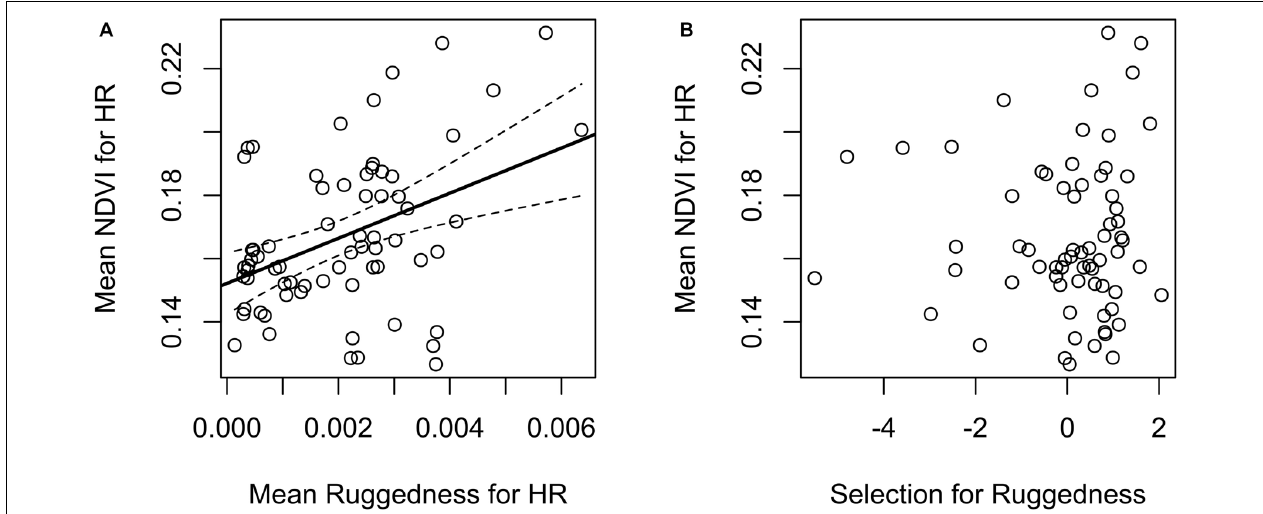
FIGURE 5 | Potential trade-offs (or lack thereof) between nutritional resources and offspring safety for female mule deer on the Mojave National Preserve (2013–2016) while provisioning young ( n = 67). (A) The left figure reveals a general positive relationship between habitat regions likely to confer offspring safety (topographic ruggedness, averaged across individual home ranges) and the availability of nutritional resources (NDVI, averaged across individual home ranges). Black solid line and dashed curve were derived from ordinary linear regression, and represent a fitted regression line and 95% confidence interval, respectively. (B) The right figure illustrates the relationship between individual-level selection coefficients for rugged terrain (logit-scale, derived from a generalized linear mixed-effects model of resource selection) vs. the availability of nutritional resources (NDVI), averaged across individual home ranges (no statistical relationship was detected).